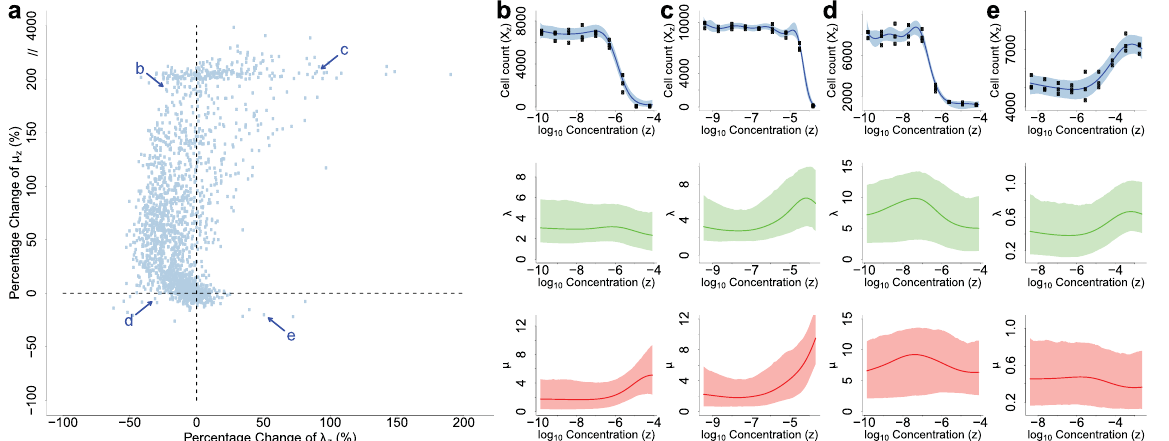
Figure 2. ( a ) Percentage change between the posterior mean estimates of death rates ( μ ( z )) at the largest and the smallest tested concentrations v.s percentage change between posterior means of birth rates ( λ ( z )). ( b–e ) Posterior estimations of Kendall Process means (dose-response curves, upper panel), birth rates (middle panel) and death rates (lower panel) of cell line HCC1954 treated with compound IKK 16 ( b ), cell line MCF7 treated with compound 4-HC ( c ), cell line HCC1428 treated with compound MG-132 ( d ) and cell line HCC202 treated with compound PS-1145 ( e ). Curves and shades represent the posterior mean and the 95% credible interval of the corresponding variables,